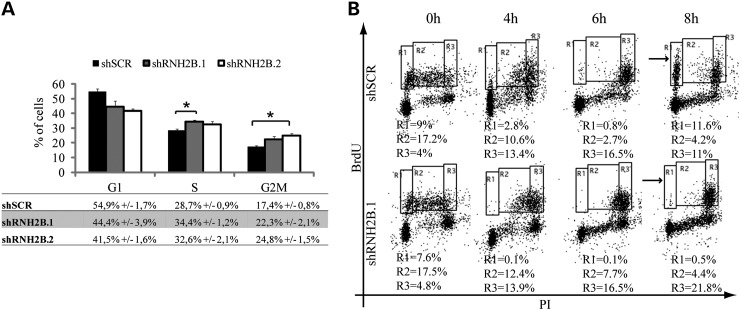
RNase H2 depletion causes a delay in S-G2 phases. Cell cycle distribution of asynchronous HeLa cells. Histograms represent the percentage of cells in G1, S and G2-M phase. FACS profiles were analyzed using CellQuest software. Data are mean ± s.e.m. of four independent experiments. *P < 0.02 (t-test) (A). Representative images of a cell kinetic experiment. Asynchronous HeLa cells were pulse labeled with BrdU and released in BrdU-free medium. Cells were harvested and stained with anti-BrdU and propidium iodide (PI) at indicated time points (hours after release). R1 = early S-phase; R2 = mid-S-phase; R3 = late S/G2 phase (arrows indicate cells entered in new G1 phase) (B).